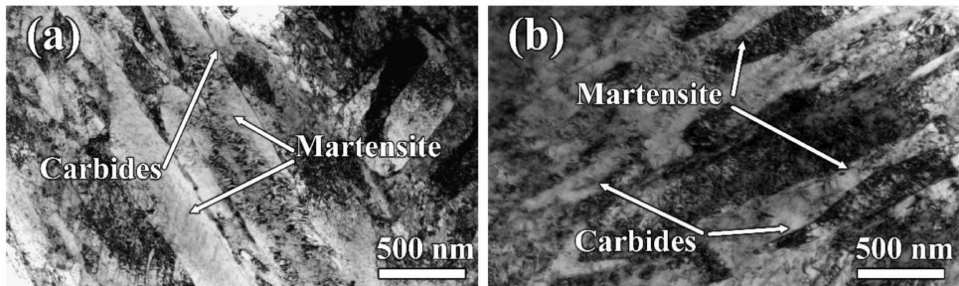
Figure 5. TEM morphologies of ( a ) H13 steel and ( b ) H13 steel manipulated by 0.02 wt.% TiC + TiB 2